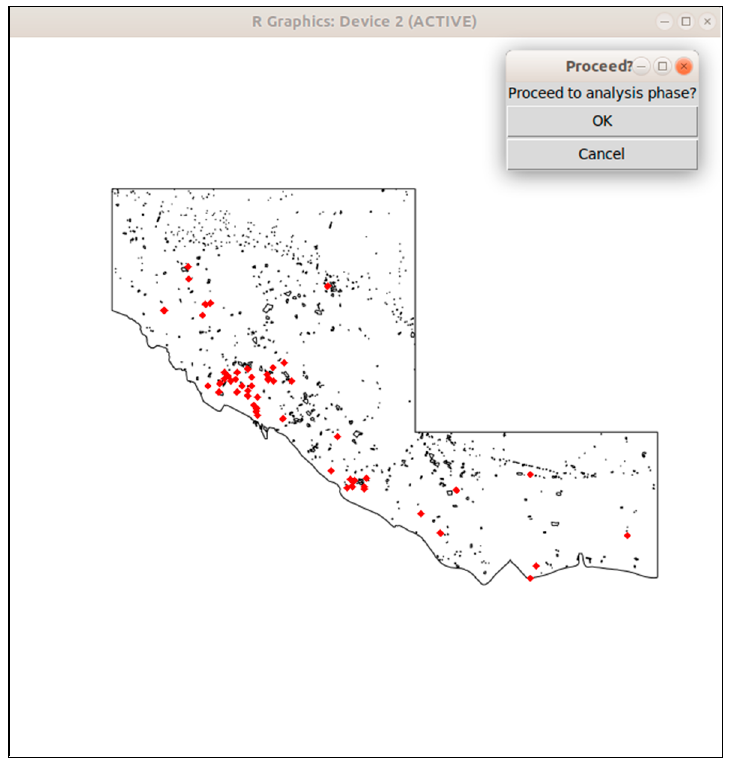
Figure A2. MCSites tool overlay maps and “Proceed” dialog.